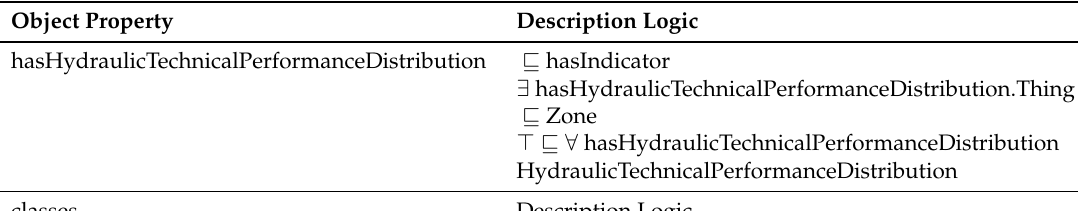
Table 2. Modeling of “Hydraulic technical performance distribution”.